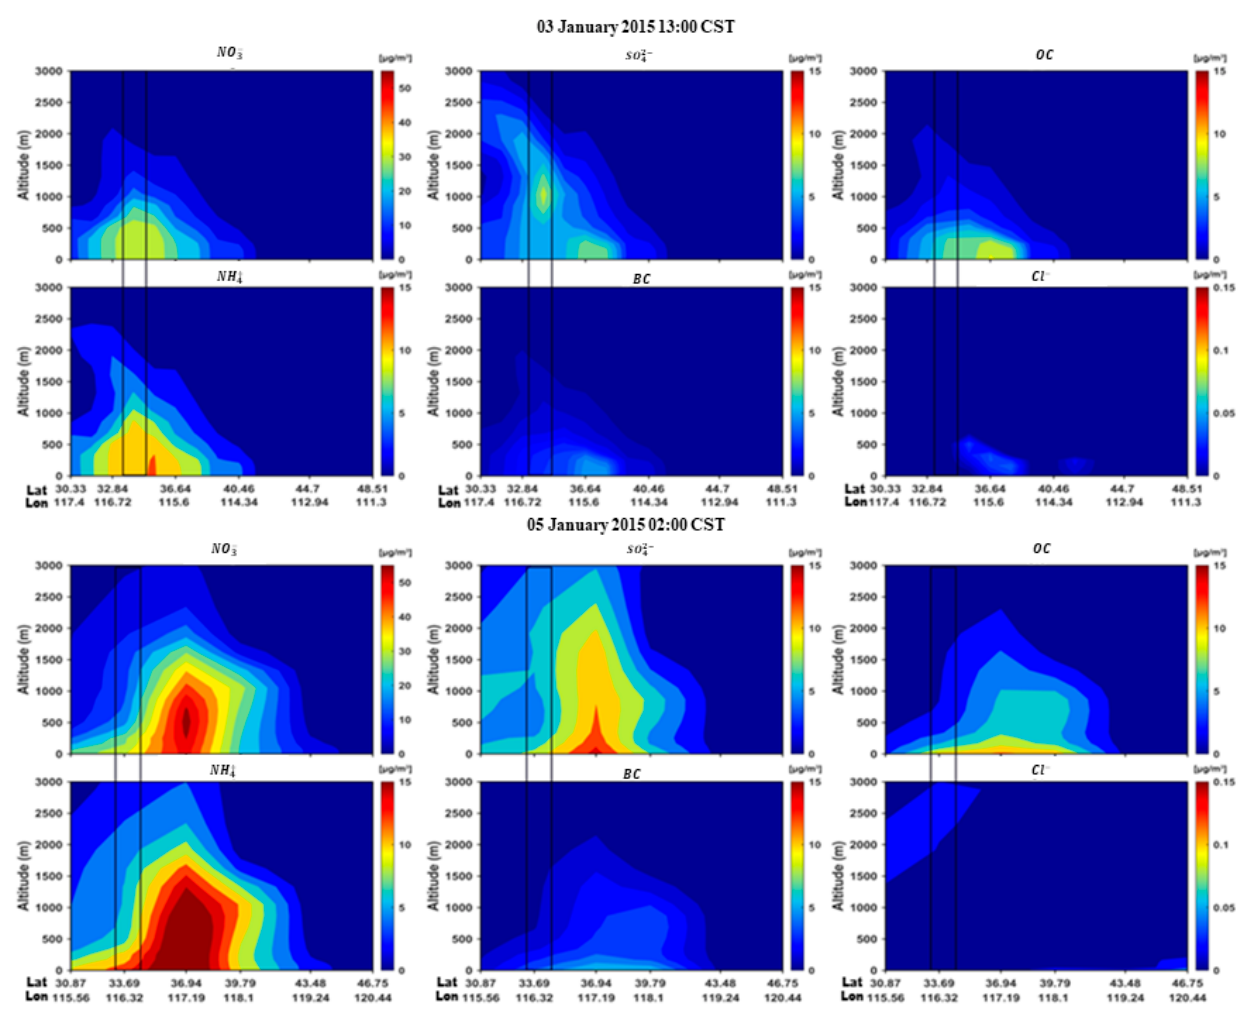
Figure 7. Vertical sections of the main components of PM 2.5 along the trajectory of CALIPSO on 3 January and 5 January 2015 (China Standard Time (CST)). The black box represents the scope of Xuzhou.